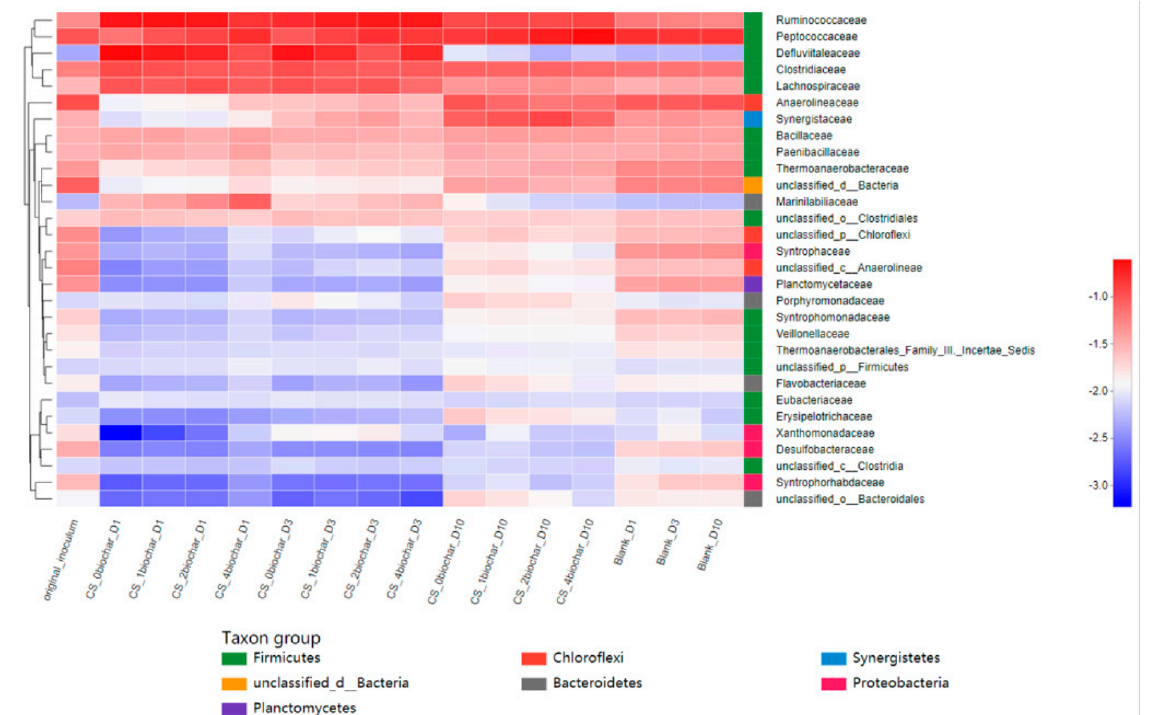
Figure 7. Heat map of sequence distribution bacteria at the family